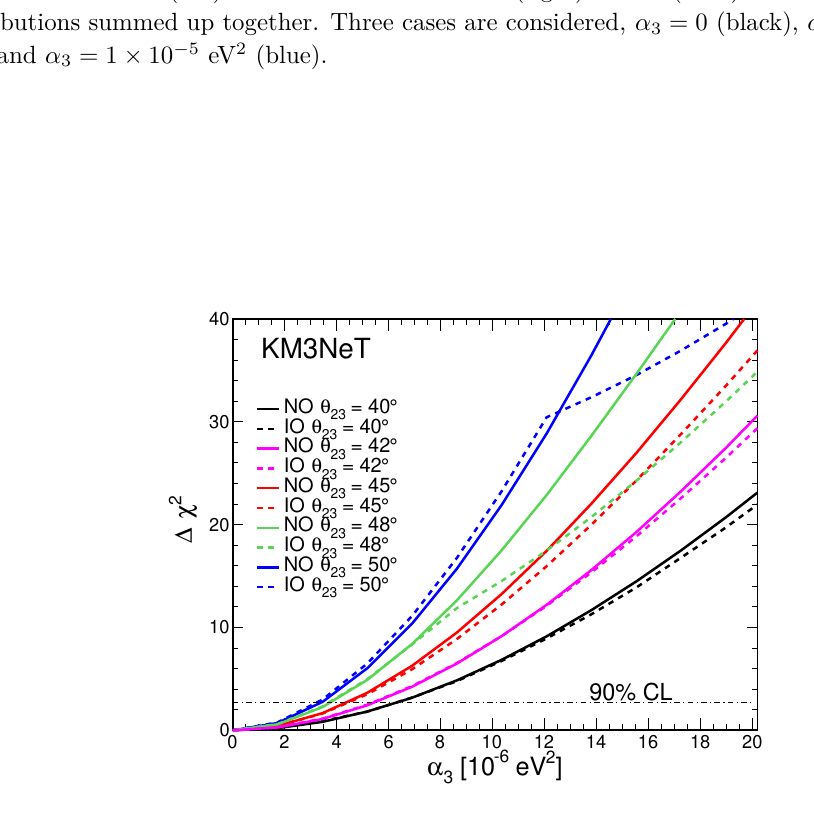
Figure 9. Sensitivity to neutrino decay for 10 years of data taking in KM3NeT/ORCA assuming NO (solid) and IO (dashed) as a function of α 3 for different values of the true θ 23